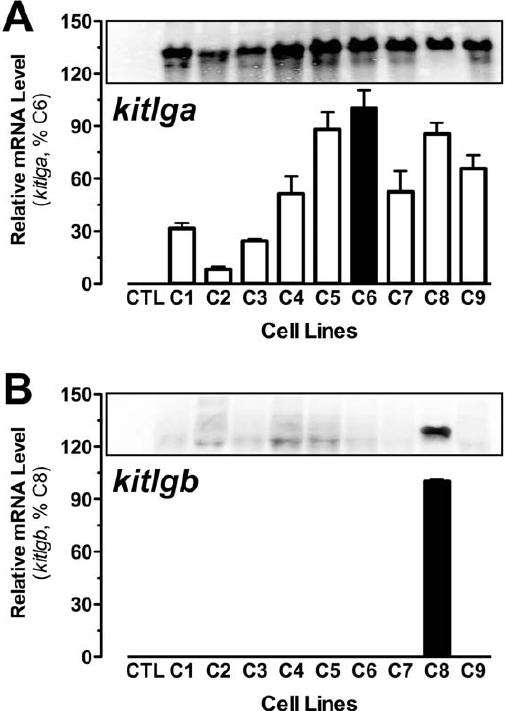
Figure 3. Characterization of recombinant CHO clones ex- pressing zebrafish Kitlga and Kitlgb. Nine clones (C1–9) for Kitlga (A) and one clone (C8) for Kitlgb (B) were chosen for analysis by real- time qPCR (bottom) and Northern blot hybridization (top). CTL, control CHO cells transfected with the vector pcDNA5/FRT.